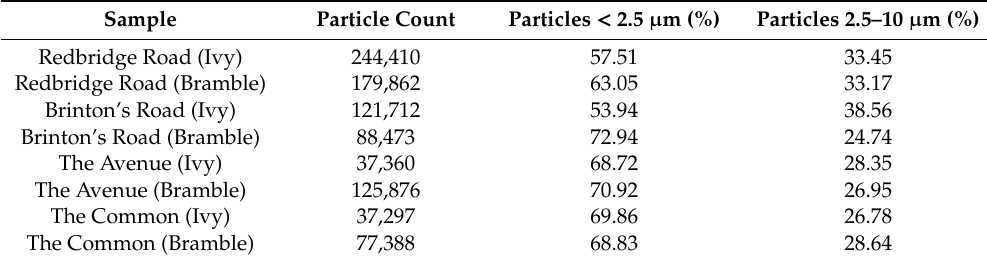
Table 1. Particle size analysis and distribution of fine ( < 2.5 µ m) and coarse (2.5–10 µ m) particles measured by physical diameter.